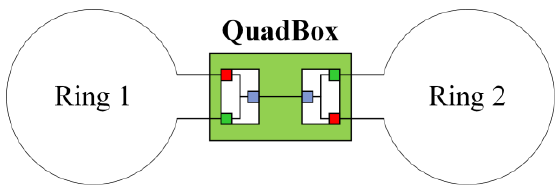
Figure 1. A QuadBox node connecting two